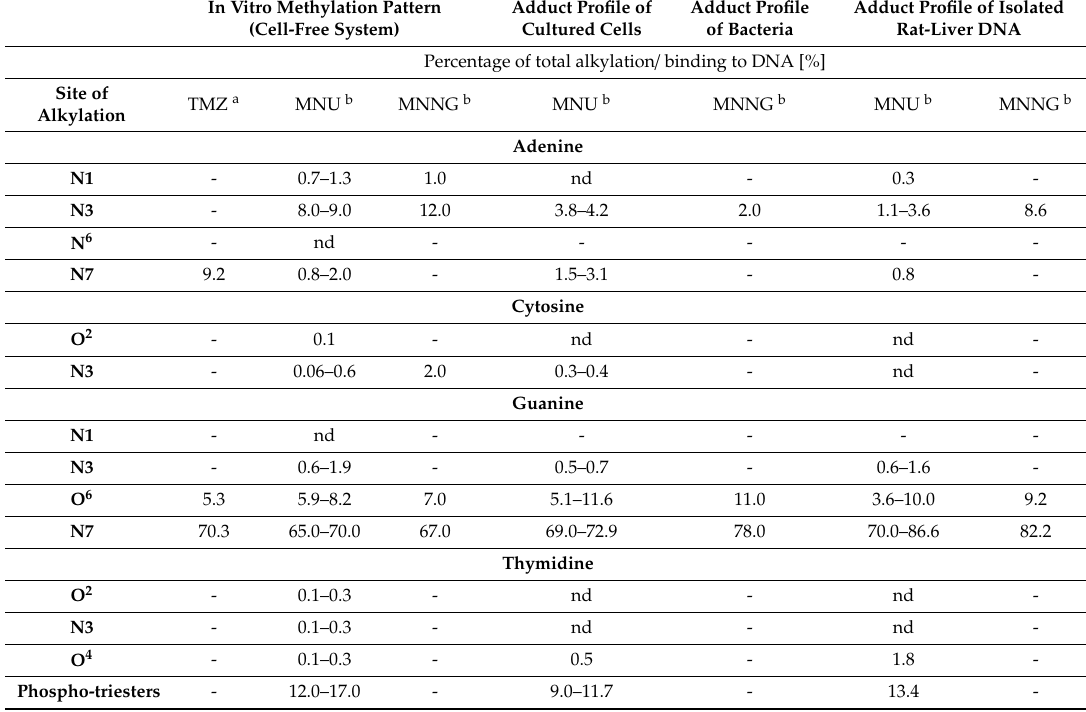
Table 1. Distribution of alkylated adducts in the DNA upon treatment with monofunctional S N 1-type alkylating agents. Methylation of DNA is expressed as percentage of total alkylation upon stimulation with temozolomide (TMZ), N -methyl- N -nitrosourea (MNU), or N -methyl- N (cid:48) -nitro-nitrosoguanidine (MNNG). (a) Data from [50]. (b) Data from [92]. Dash: data not reported; nd: adduct not detected or below detection limit of the respective assays